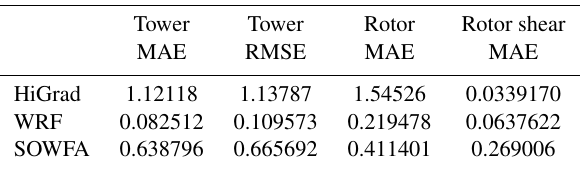
Table 7. Analysis of high-resolution LES performance using differ- ent models with the Lilly SFS parameterization for the convective ABL observed on 17 August